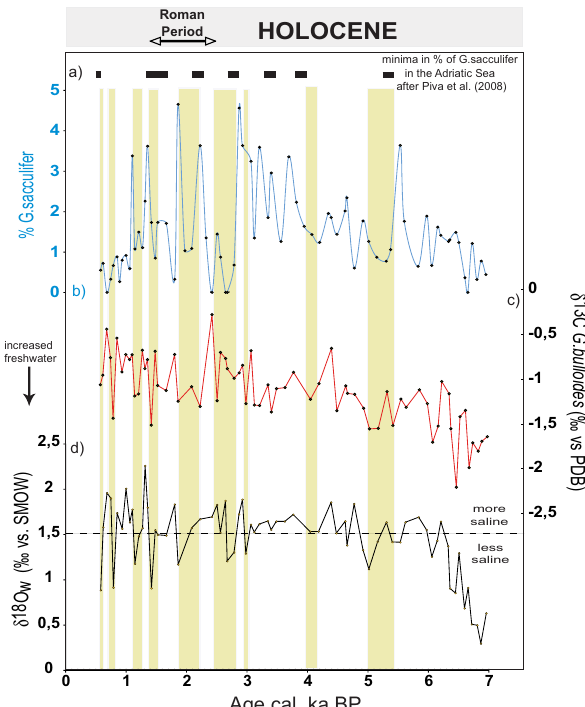
Fig. 5. Comparison of the surface dwelling foraminifera Glo- bigerinoides sacculifer abundance and hydrological changes in core MD90-917 vs. age (cal.kaBP). (a) G. sacculifer minima events recorded in the Adriatic Sea (Piva et al., 2008). (b) Percentage of G. sacculifer in core MD90-917. (c) δ 13 C of the planktonic foraminifera G. bulloides . (d) Sea water δ 18 O record ( δ 18 O w ) . Yel- low bars indicate δ 18 O w /salinity and G. bulloides δ 13 C